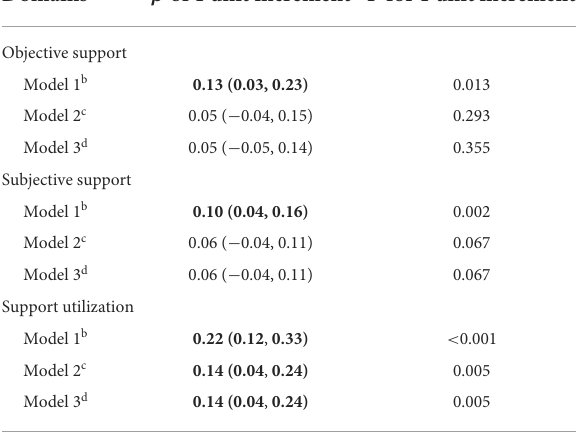
c Model2:adjustedformodel1 + educationlevel,maritalstatus,smokingstatus,andalcoholintake. d Model3:adjustedformodel2 + bodymassindex,hypertension,anddiabetes. Boldvaluesmeans P < 0.05. TABLE 4 The relationship between three domains of social support and MMSE score in multiple linear regression a . Domains β of 1 unit increment P for 1 unit increment